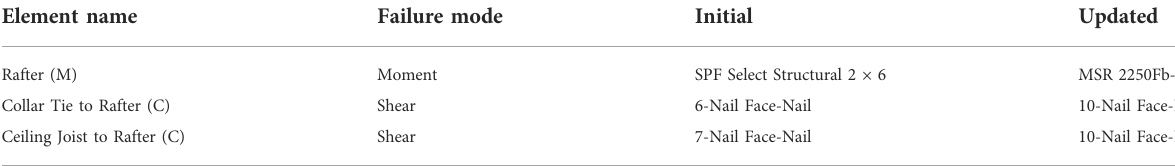
TABLE 6 All of the updated connections (C) and members (M) due to snow loading in order of failure.